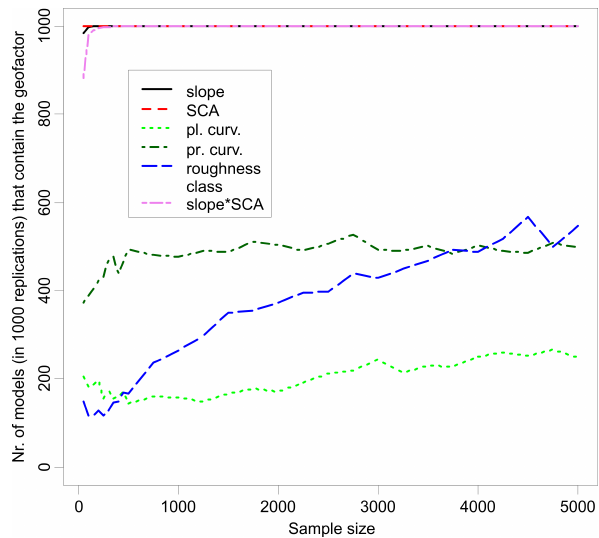
Fig. 3. Overview of the six geofactors and their contribution to 1000 models of different sample sizes. The y axis denotes the number of models for which the respective geofactor was selected. ”slope*SCA” signifies the interaction term of the two variables slope and specific catchment area.